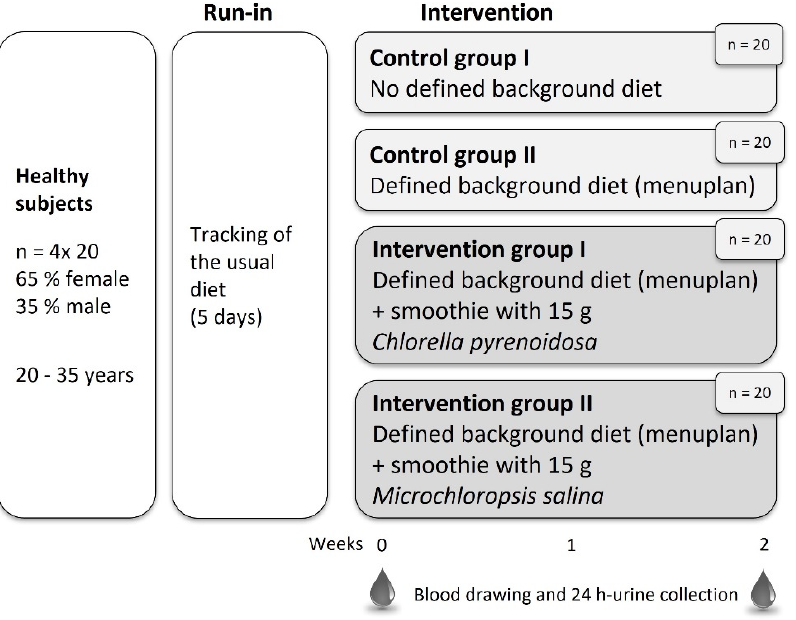
Figure 1. Design of the 4-arm randomized controlled NovAL intervention